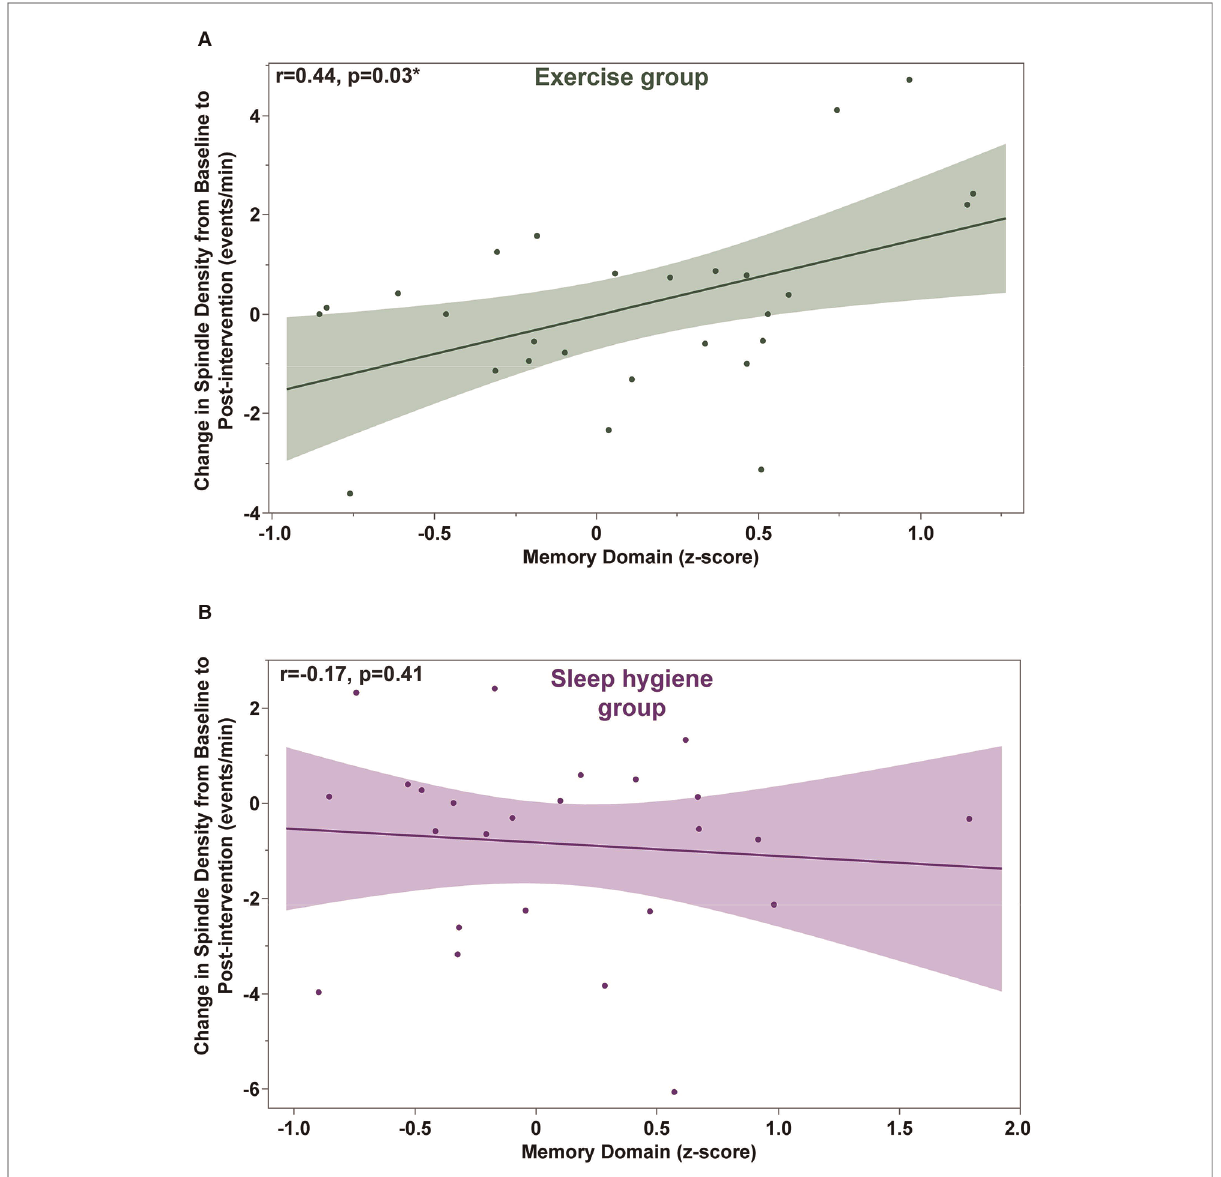
FIGURE 4 Exercise-induced changes in spindle density during the fi rst half of the night are signi fi cantly correlated with changes in the memory domain scores ( A ). No signi fi cant correlations were found in the sleep hygiene group ( B